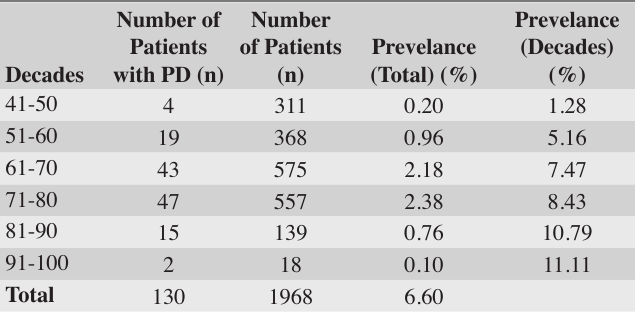
Table 1. The Number of Patients and Percentages by Decades